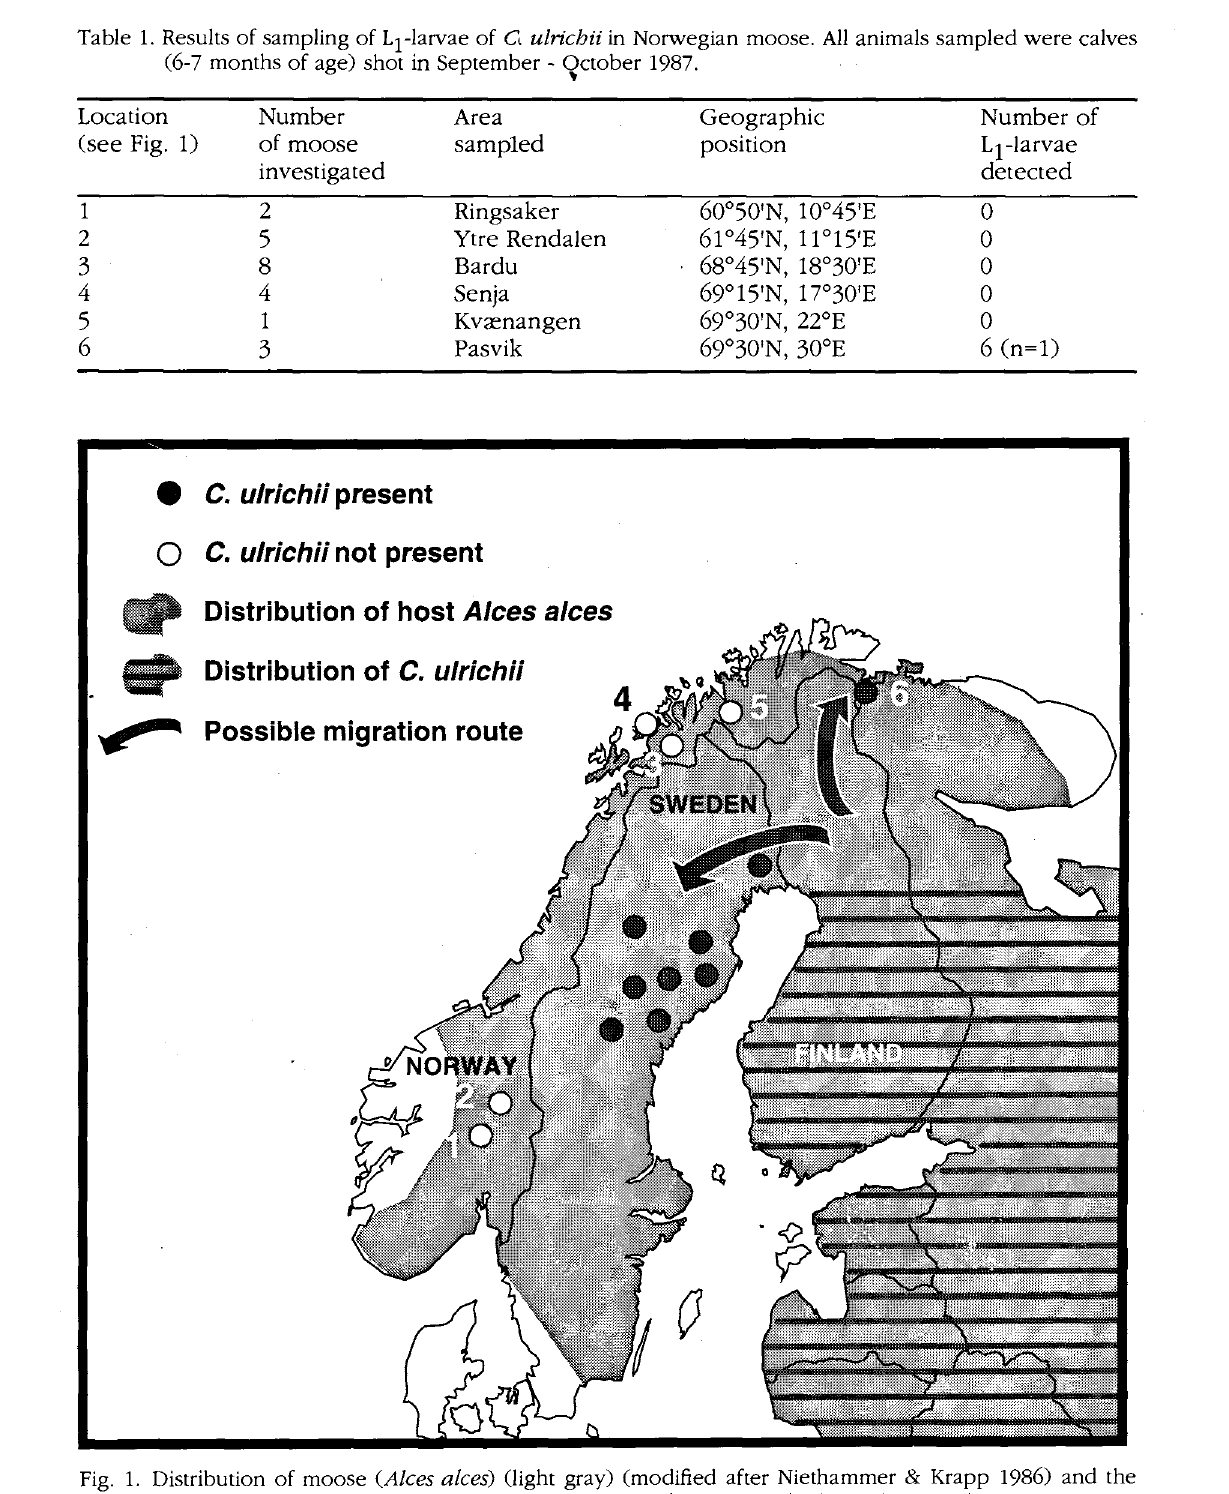
Fig. 1. Distribution of moose (Alces akes) (light gray) (modified after Niethammer & Krapp 1986) and the known distribution of moose nose bot fly {Cephenemyia ulrichii) (hatched areas) in northernmost Europe (Brander, 1963, Valtonen, 1972, Leena Oksanen, pers. comm.). The finds in Sweden are from 1979-86 as reported by Stéen et al. (1988). The arrows show the probable invasion routes of the